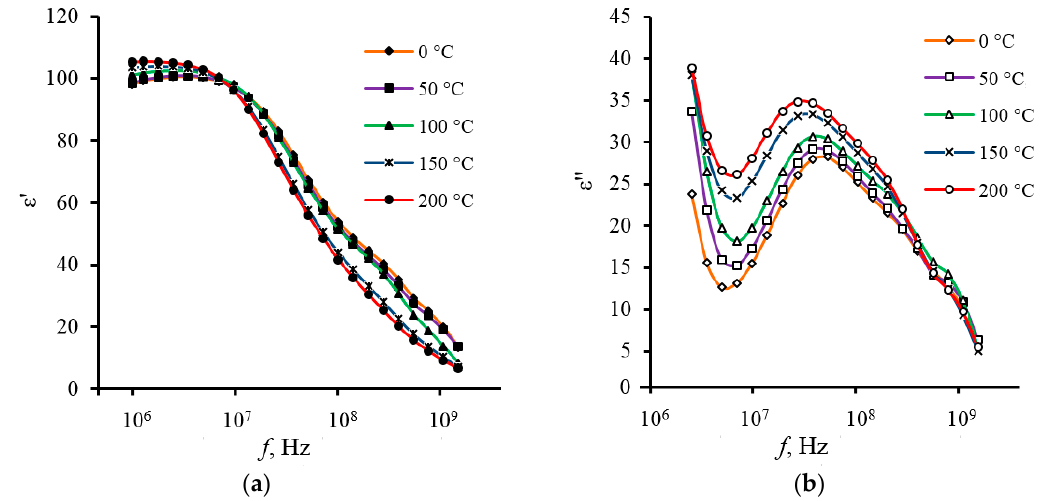
Figure 4. The frequency dependences of the real ( a ) and imaginary ( b ) parts of dielectric constant of PZT/polybenzoxazole composite (sample thickness is 12 µm; volume fraction of the PZT filler is about 35%) measured at different temperatures.